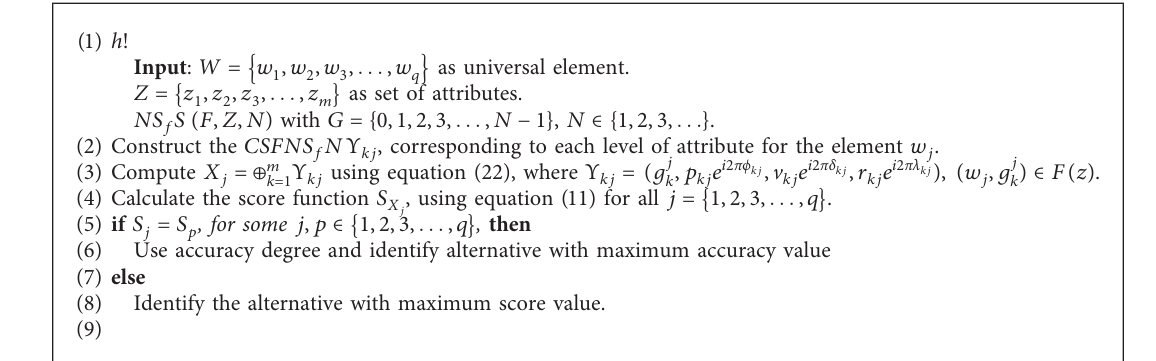
A LGORITHM 2: The algorithm of choice values of CSFNS f Ss